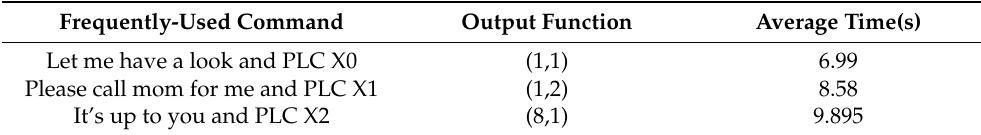
Table 4. Timetable for word combination